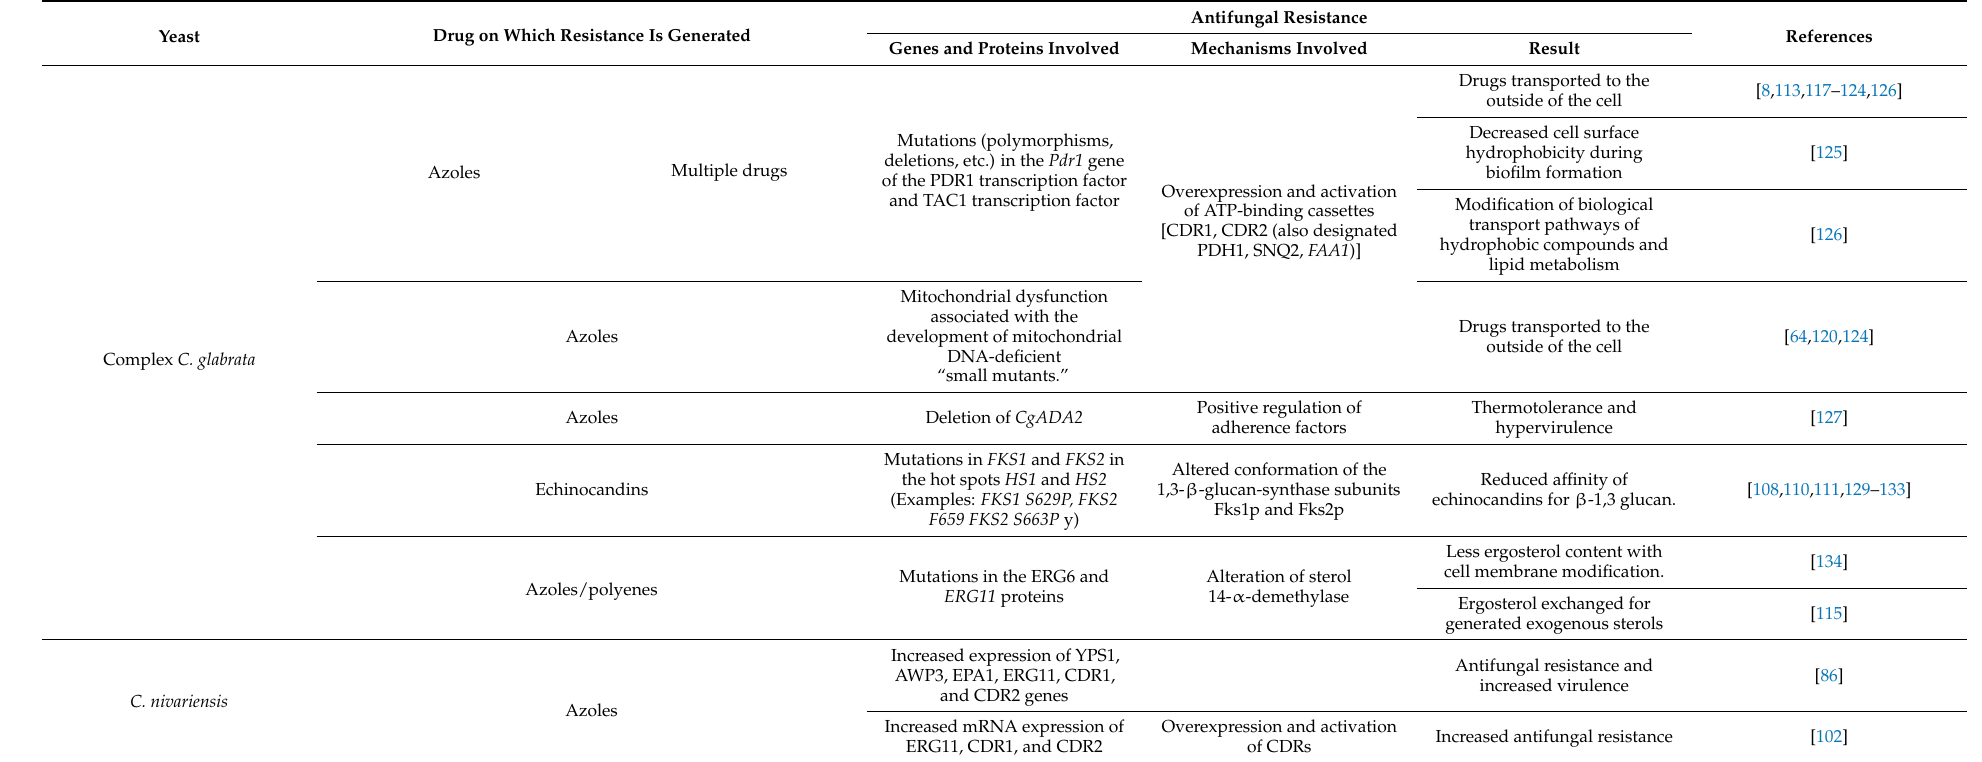
Table 2. Drug resistance fluctuations caused by the type of Candida and genetic